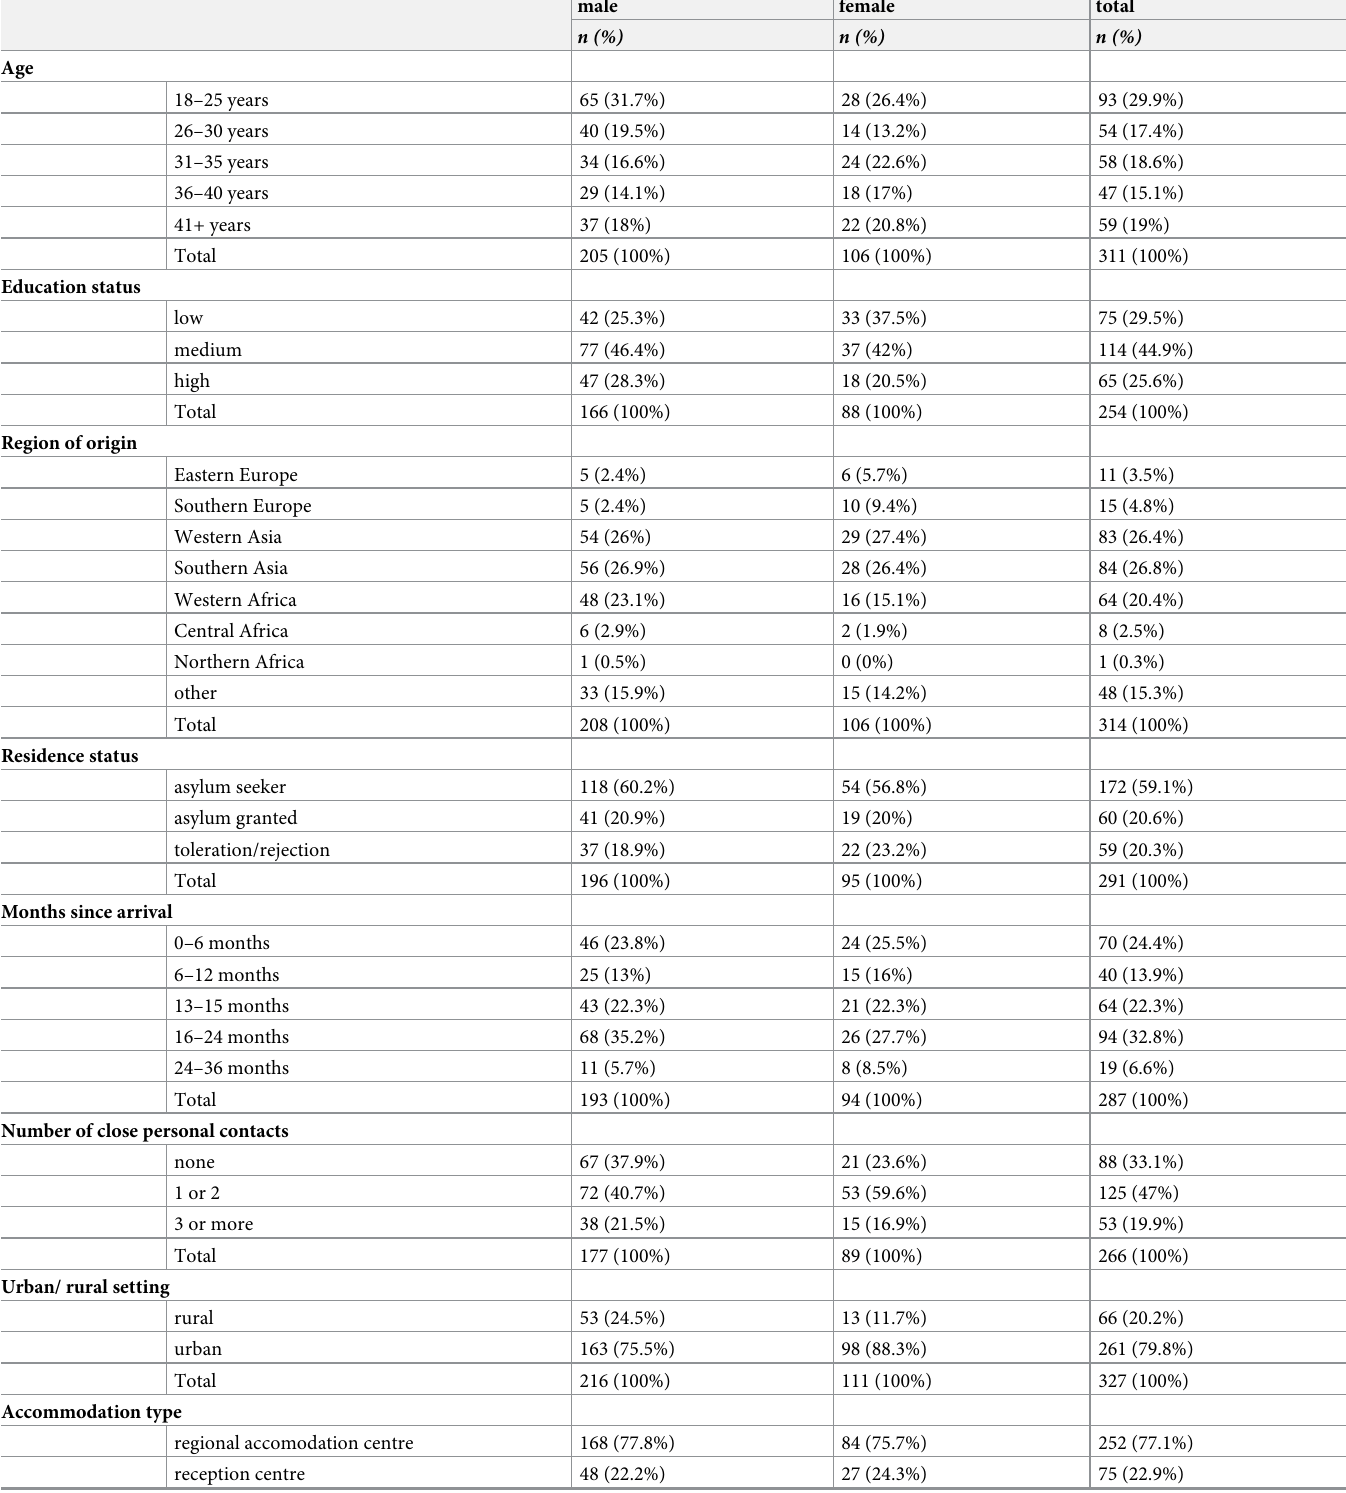
Table 2. Sociodemographic characteristics of participants, by